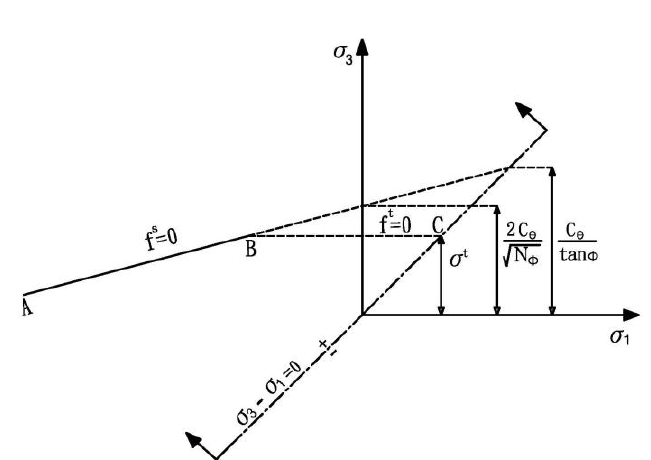
Fig. 3. Modified Mohr-Coulomb yield